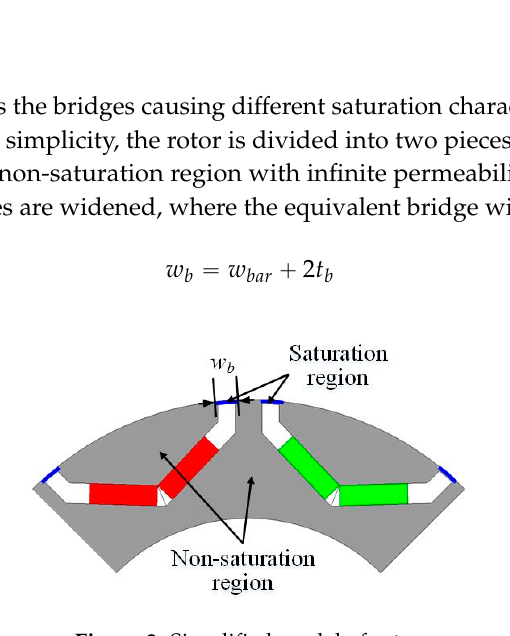
Figure 2. Simplified model of rotor.